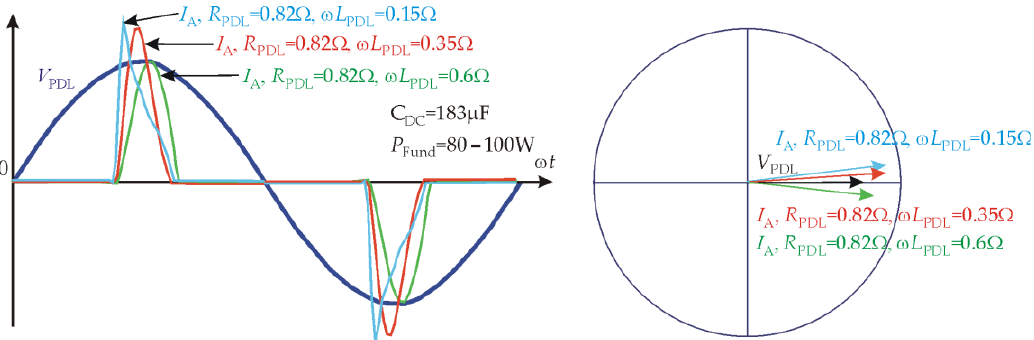
Figure 12. Time and phase diagrams of the current at the point of connection of single-phase diode rectifier supply-side device to the PDL in the case of different PDL internal resistance and inductivity. 3.3. Experimental Analysis of the Reactive Power in PDL Loaded by LED Light and Diode Recti-